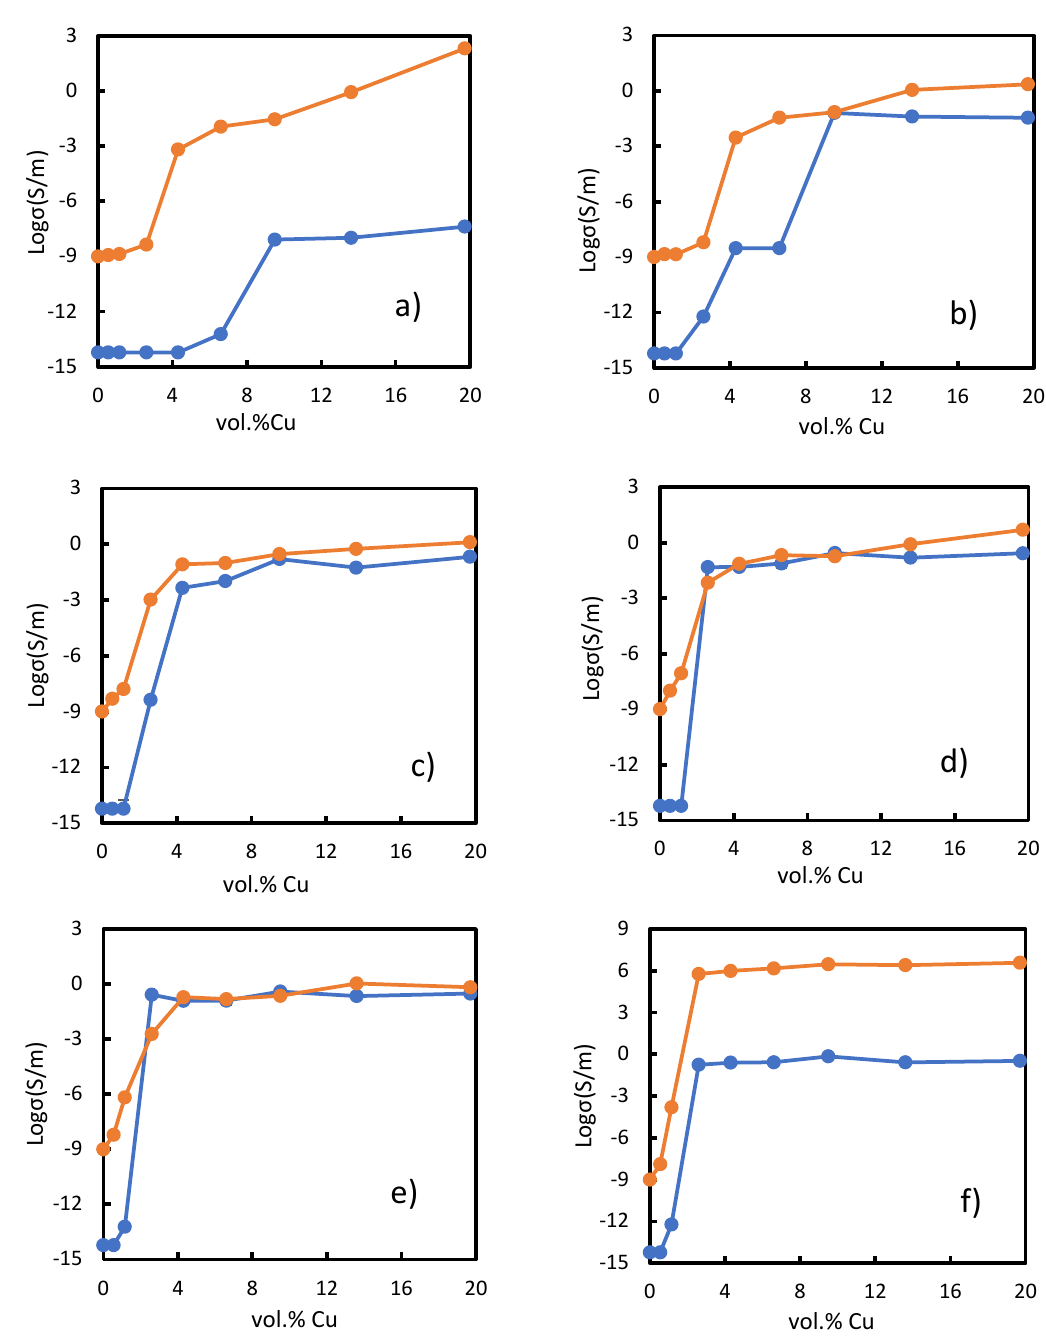
Figure 11. Comparison between the electrical conductivity of experimental and simulation results